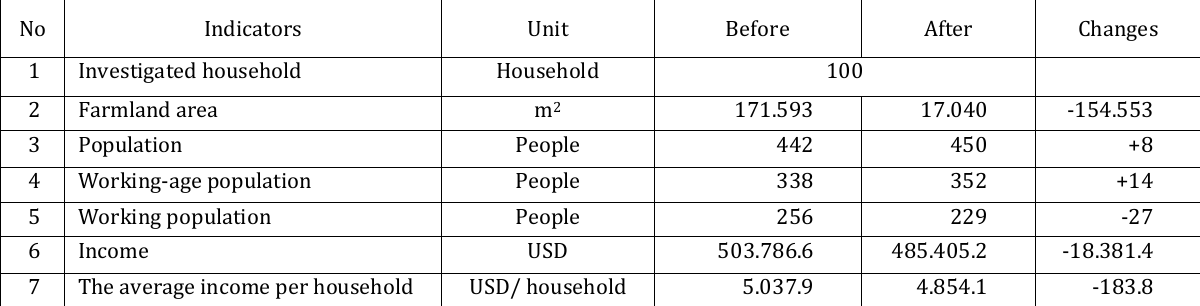
Table 1. Some indicators of investigated households in study area (Source: Households' survey,